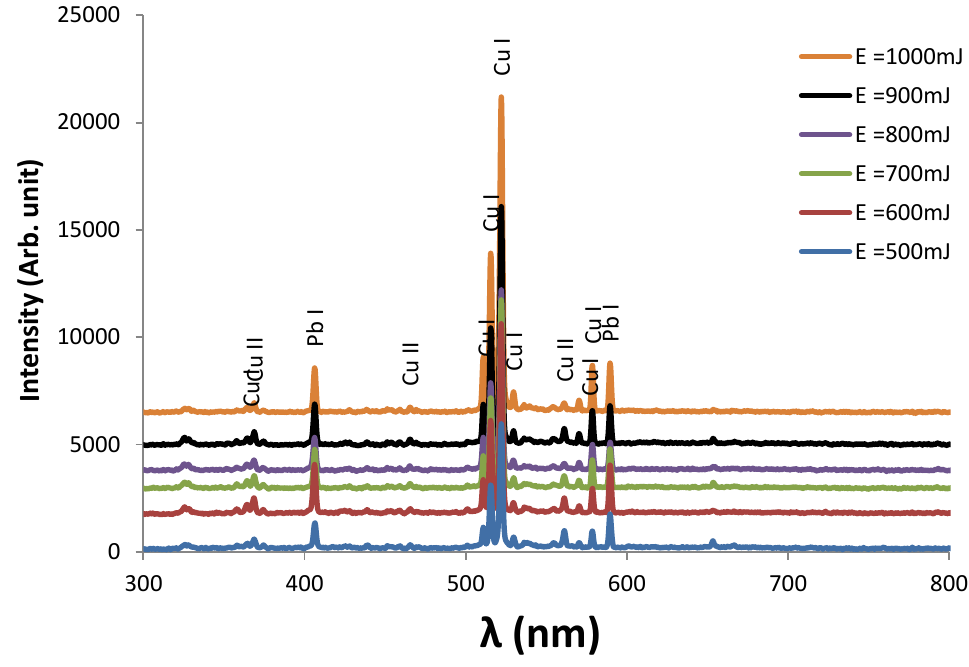
Fig. 4: Emission spectra of laser induced on CuO:Pb component at X=0.8 target in vacuum with different laser